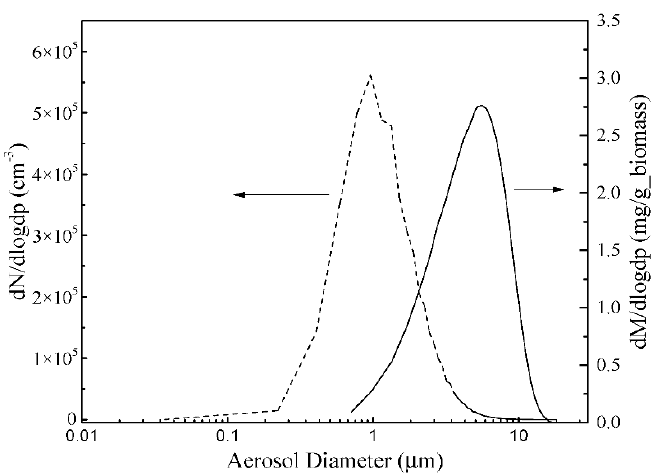
Figure 2. The Mass and number particle size distributions of the fly ash particles are from pulverized biomass combustion, assuming the stochastic fragmentation